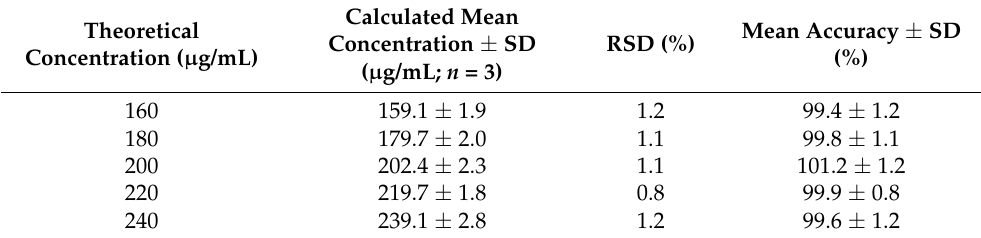
Figure 3. ( a ) Chromatogram of methionine suspension in 1 M HCl less than 15 min after mixing (Met retention time ~6.5 min); ( b ) Chromatogram of methionine suspension in 1 M HCl after 72 h at 70 °C with a degradation product detected at 4.2 min. Insert on the right panel pointed by an arrow: UV spectra of the 6.5 min eluted peak with x axis: wavelength (200–300 nm) and absorbance response y axis (mAU). Table 2. Precision and accuracy of the calibration